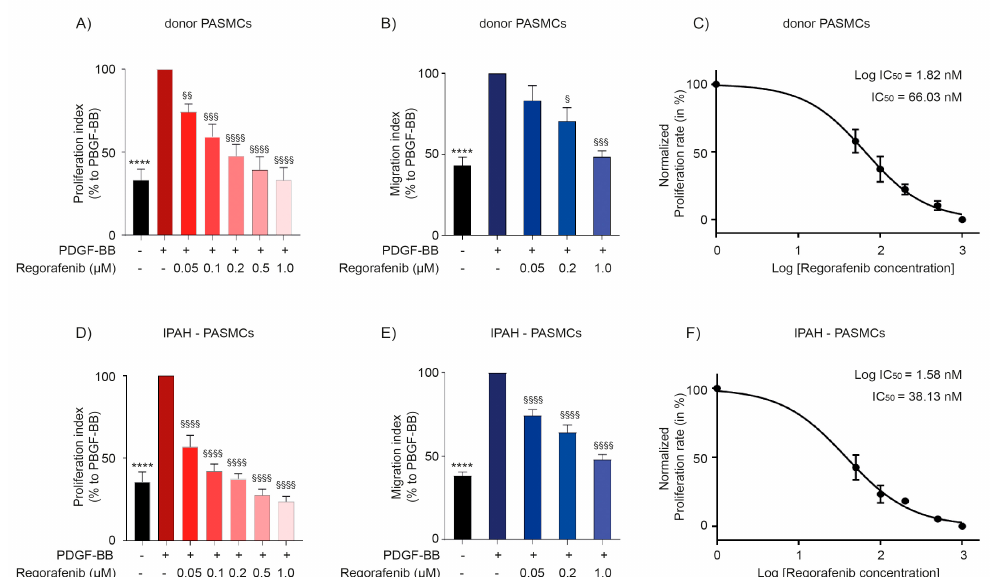
Figure 2. Effect of regorafenib on proliferation and migration of human pulmonary arterial smooth muscle cells. Proliferation index measured by BrdU incorporation assay in ( A ) donor PASMCs ( n = 6) and ( D ) IPAH-PASMCs ( n = 6) stimulated with PDGF-BB followed by treatment with regorafenib in a dose-dependent manner. Migration index measured by transwell migration assay in ( B ) donor ( n = 3) and ( E ) IPAH ( n = 4) PASMCs stimulated with PDGF-BB followed by treatment with regorafenib in a dose-dependent manner. IC 50 values were calculated from proliferation rate in ( C ) donor and ( F ) IPAH-PASMCs. **** p < 0.0001, versus DMSO control; §§§§ p < 0.0001, §§§ p < 0.001, §§ p < 0.01, and § p < 0.05 versus PDGF-BB treatment (30 ng/mL). Data represent the mean ± SEM.